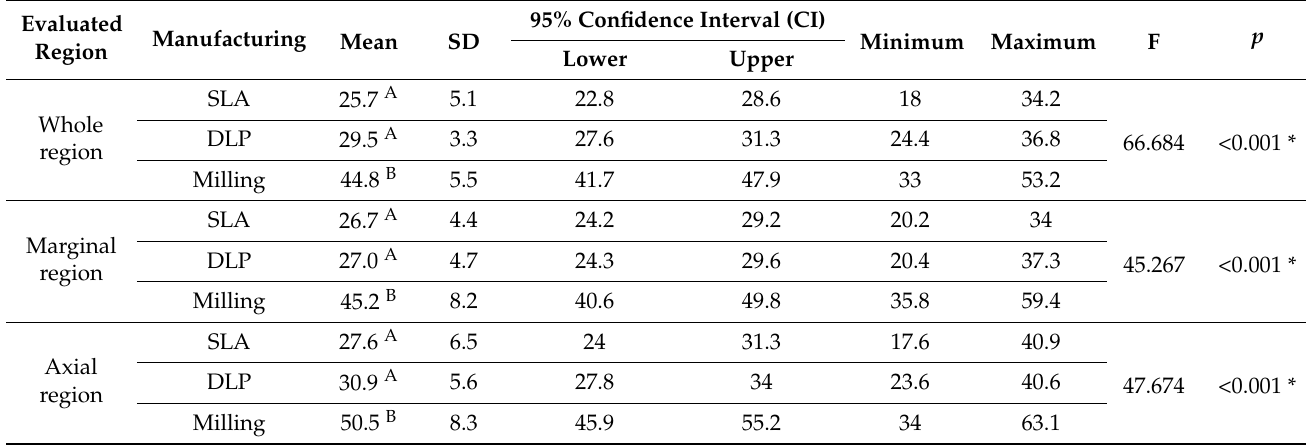
Table 1. Comparison of intaglio surface trueness ( µ m) of interim crowns fabricated with SLA 3D printing, DLP 3D printing, and milling